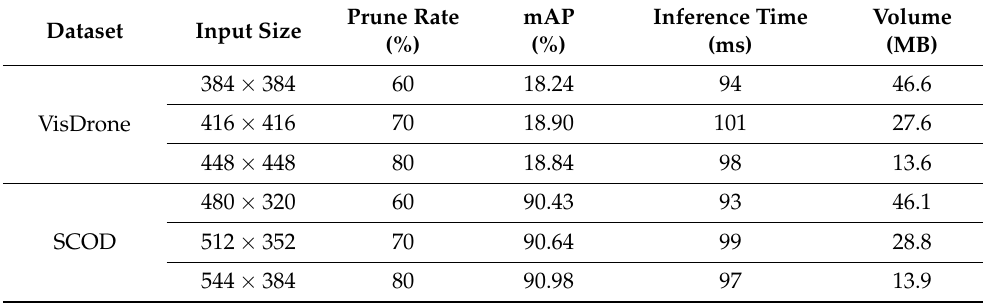
Table 7. Detection performance according to input image resolution and pruning